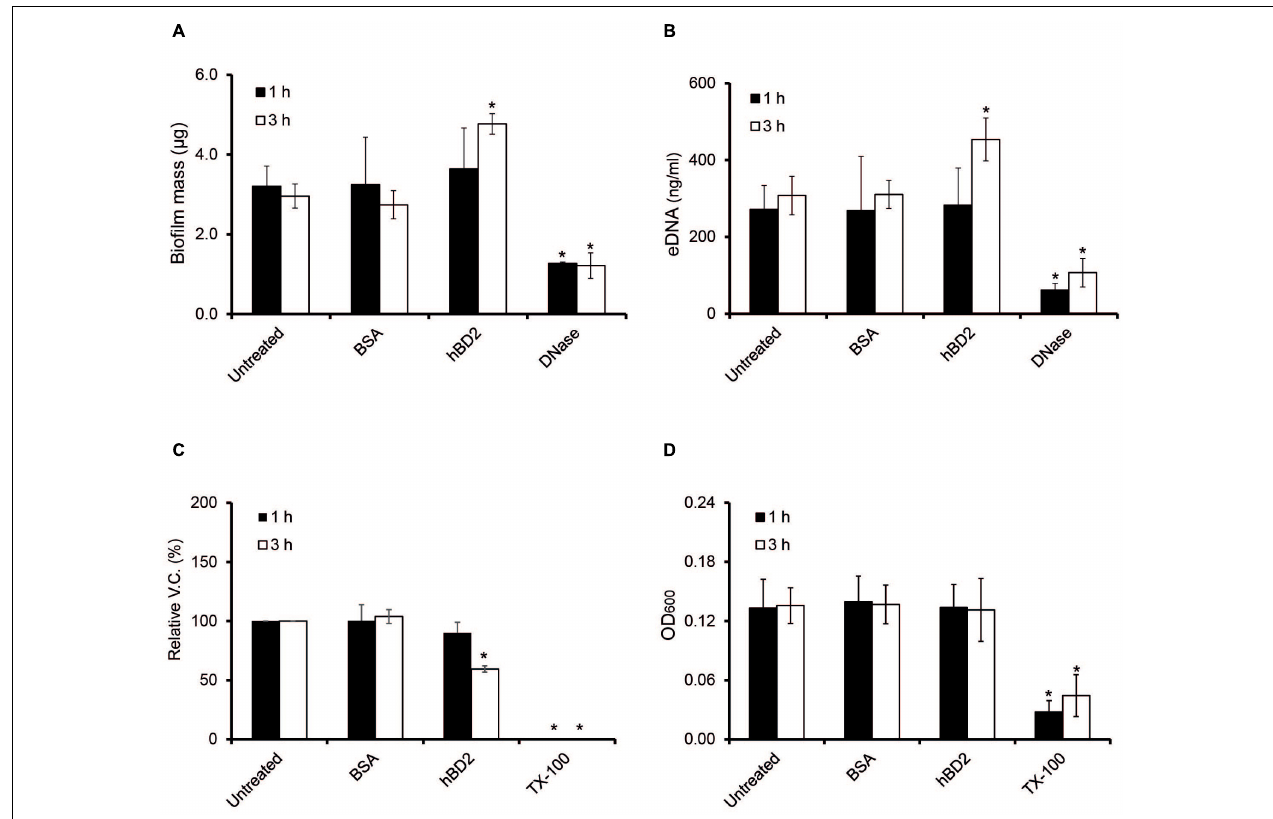
FIGURE 7 | Meningococcal biofilms after hBD2 treatment. Meningococcal biofilms were allowed to form under static conditions for 24 h before incubation with 5 µ M BSA or 5 µ M hBD2. (A) Biofilm mass was detected by crystal violet. (B) Detection of eDNA in meningococcal biofilm was performed using Quant-iT PicoGreen DNA assay kit. (C) Biofilm was dissolved and viable bacteria quantified by plating. (D) OD 600 of dissolved biofilm. Treatment with 200 µ g/ml DNase I was used as negative control in panels (A,B) , and 0.5% Triton X-100 (Tx-100) was used as negative control in panels (C,D) . DNase I was only used as negative control for the measurement and was never added together with hBD2. Data are represented as the mean values, with error bars representing the standard deviation. All experiments were performed in quadruplicates at least three times. Significance was compared with the untreated biofilm at 1 or 3 h. * P <